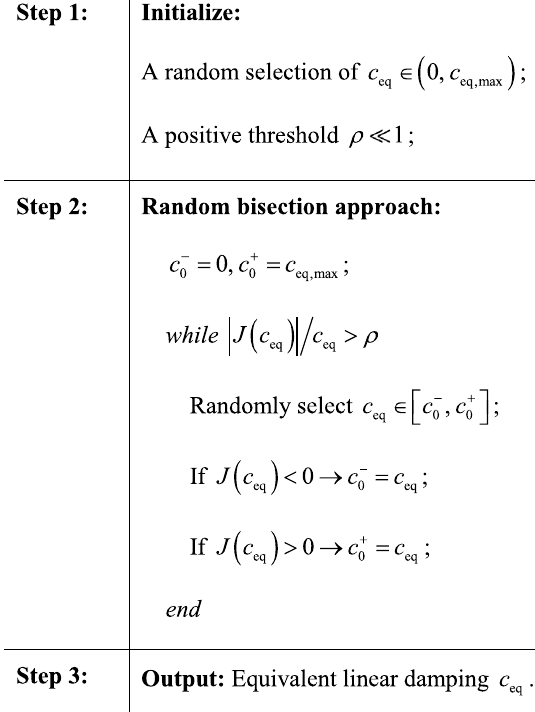
Algorithm 1. The bisection searching algorithm